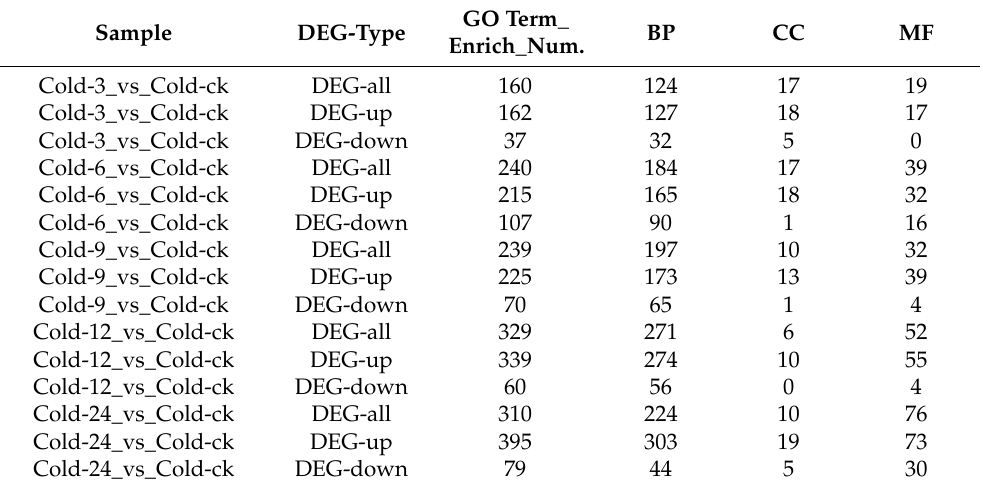
Table 1. GO enrichment analysis statistics of DEGs ( p -value ≤